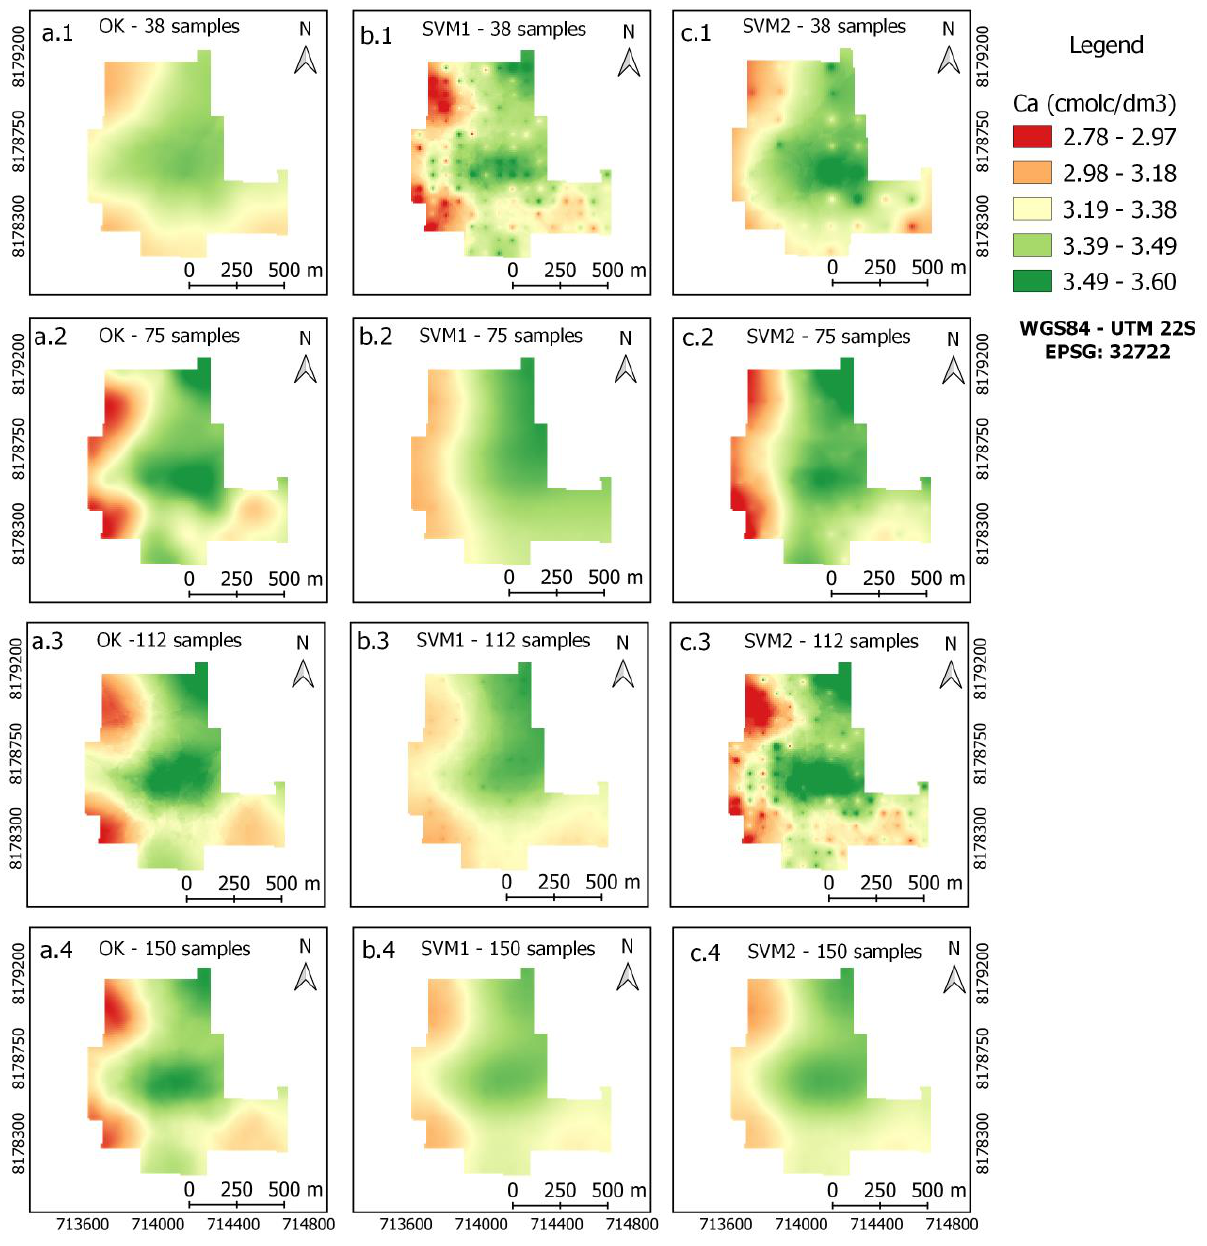
Figure 11. Maps obtained by interpolation of Calcium (Ca 2+ ): ( a ) OK, ( b ) SVM1 , ( c ) SVM2 ; Set of points (training): 38 ( a.1 – c.1 ), 75 ( a.2 – c.2 ), 112 points ( a.3 – c.3 ), and 150 points ( a.4 – c.4 ).